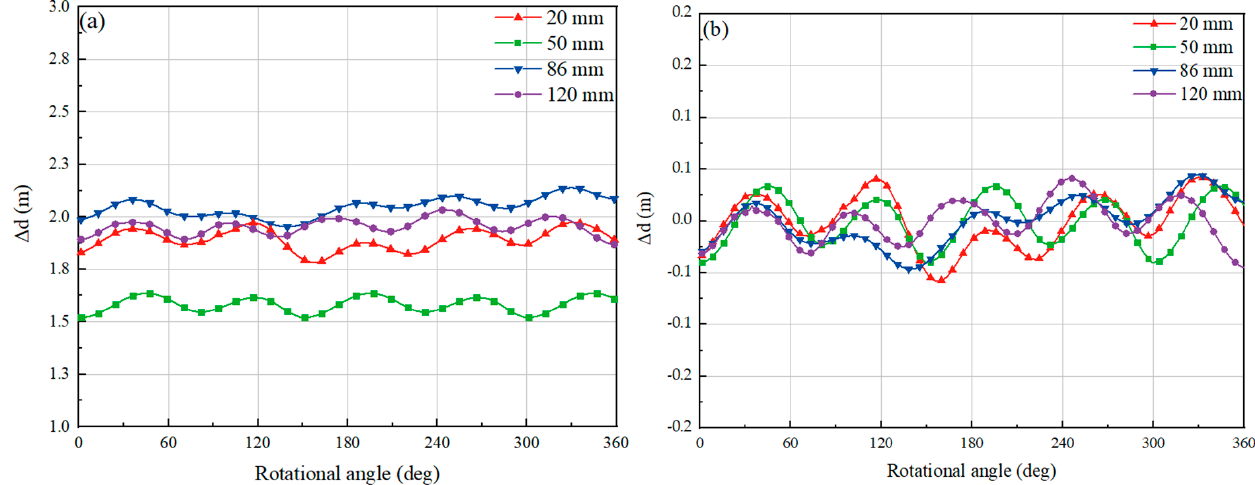
Figure 6. Difference in water level, ∆ d in a cycle ( a ); Difference in non-dimensional parameter ∆ d p in a cycle ( b ).